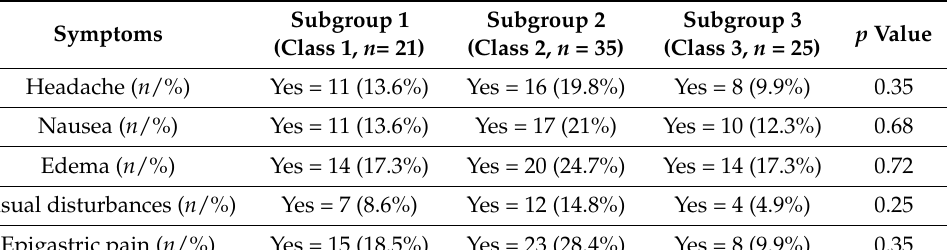
Table legend: PE—preeclampsia; SD—standard deviation; g- grams; NICU—neonatal intensive care Table legend: LDH—lactate dehydrogenase; AST—asparate aminotransferase; PLT—platelets; SD—standard unit. deviation; APRI—aspartate-aminotransferase to platelet ratio index; SBP—systolic blood pressure; DBP—diastolic blood pressure. Table 4. Comparison of the main symptoms between analyzed subgroups.